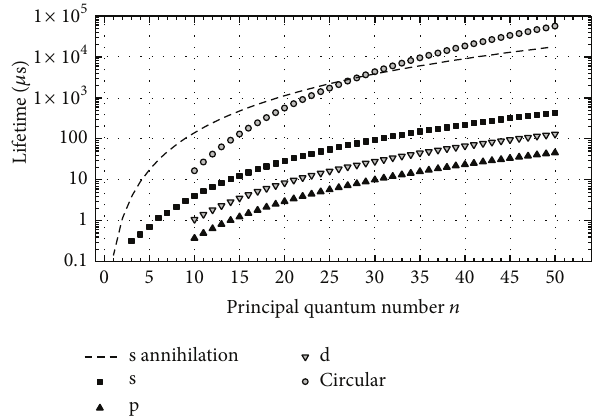
Figure 9: Radiative lifetimes of various Ps states as a function of the principal quantum number 𝑛 . The lifetimes were calculated by summing the Einstein 𝐴 coefficients of all electric-dipole-allowed decay channels from each Rydberg state. For each 𝐴 coefficient the appropriate radial integrals were determined using analytic expressions for the radial wave functions in a pure Coulomb potential[53].Thedashedlineistheannihilationlifetimeof 𝑛 sstates. After [5].